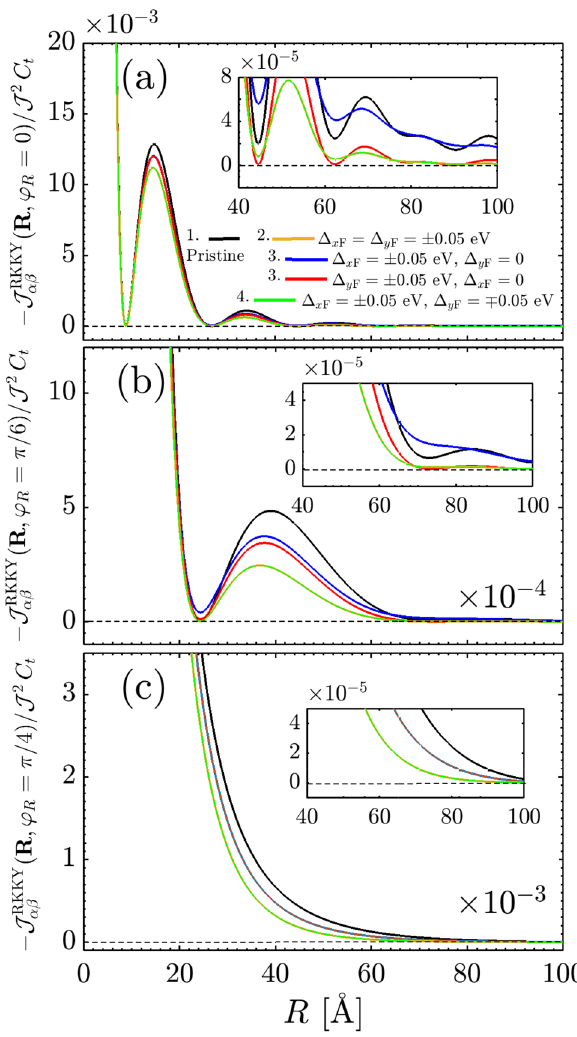
Figure 13. The behavior of the susceptibility ferroelectric distortion potentials at ( a ) ϕ R